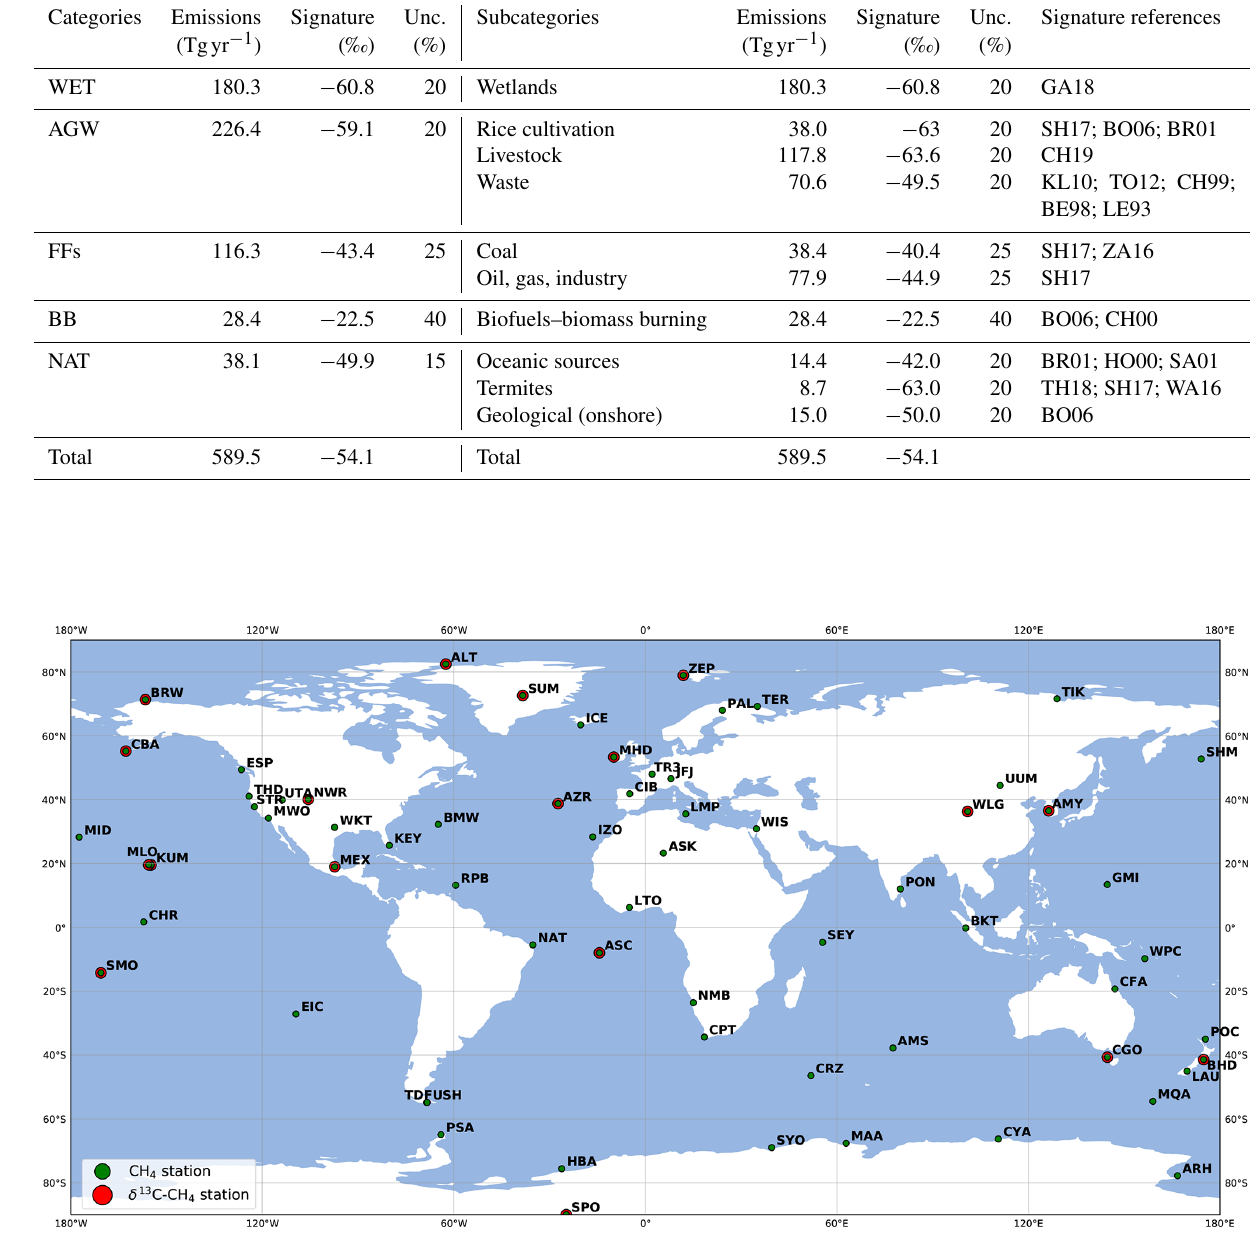
Figure 2. Locations of CH 4 and δ 13 C ( CH 4 ) surface stations. Affiliated networks are not displayed. More information can be found in Tables S3 and S4 in the